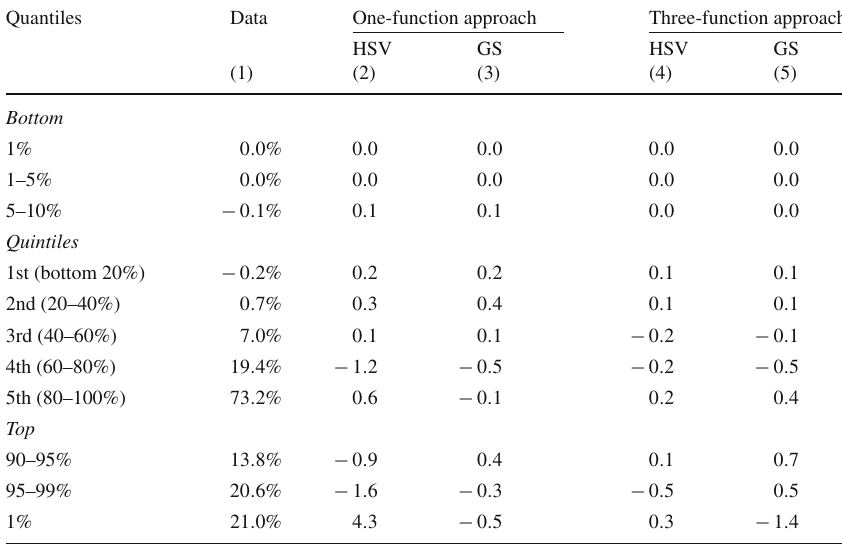
Table 13 Evaluation of tax functions: distribution of tax liabilities in 2015 (percentage points difference with respect to the data) Quantiles Data One-function approach Three-function approach